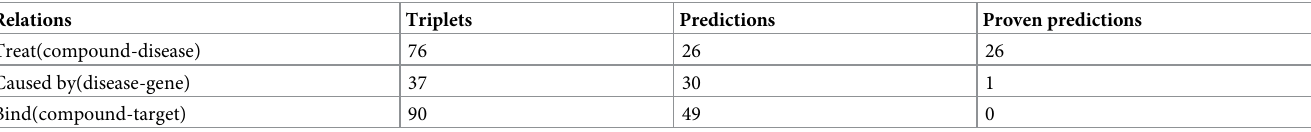
Table 10. Matching results of drug-disease-gene top 100 paths with database. “Number of triplets” is the number of triplets in specific relation involved in top 100 paths. “Predictions” is the number of relations neither in data sets nor in chosen databases. “Proven predictions” is the number of relations not in data sets but matched with chosen